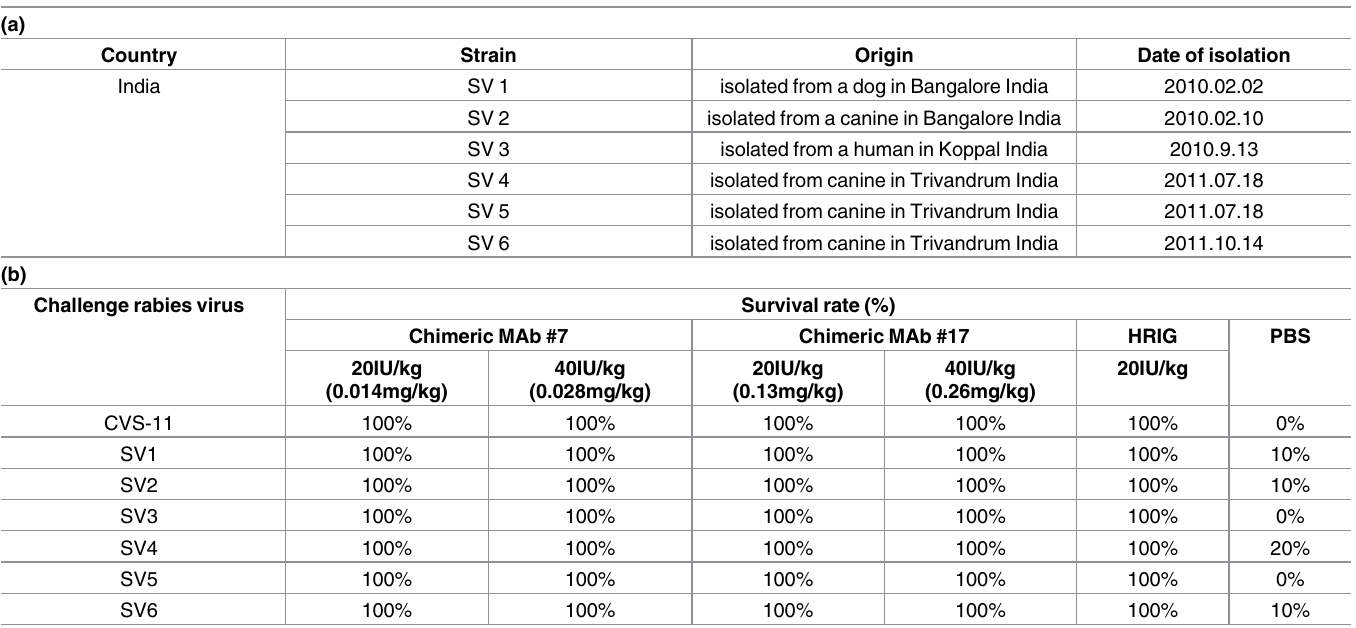
Table 4. Anti- RABV MAbs protect mice against lethal RABV infection.